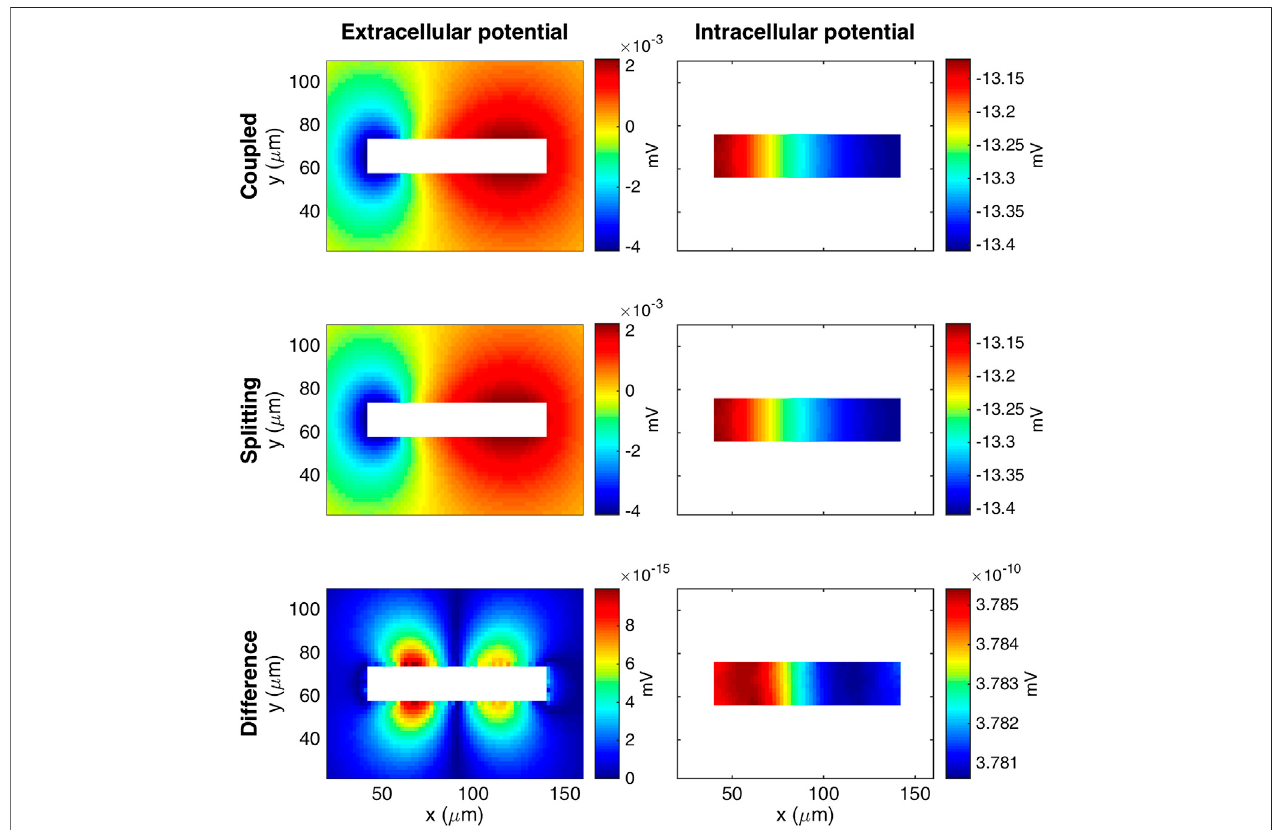
FIGURE 5 | Comparison of the solutions of the coupled and splitting approaches for the EMI model like in Figure 4 , except that we use fi ve iterations, N it (cid:2) 5, instead of one in the splitting approach.